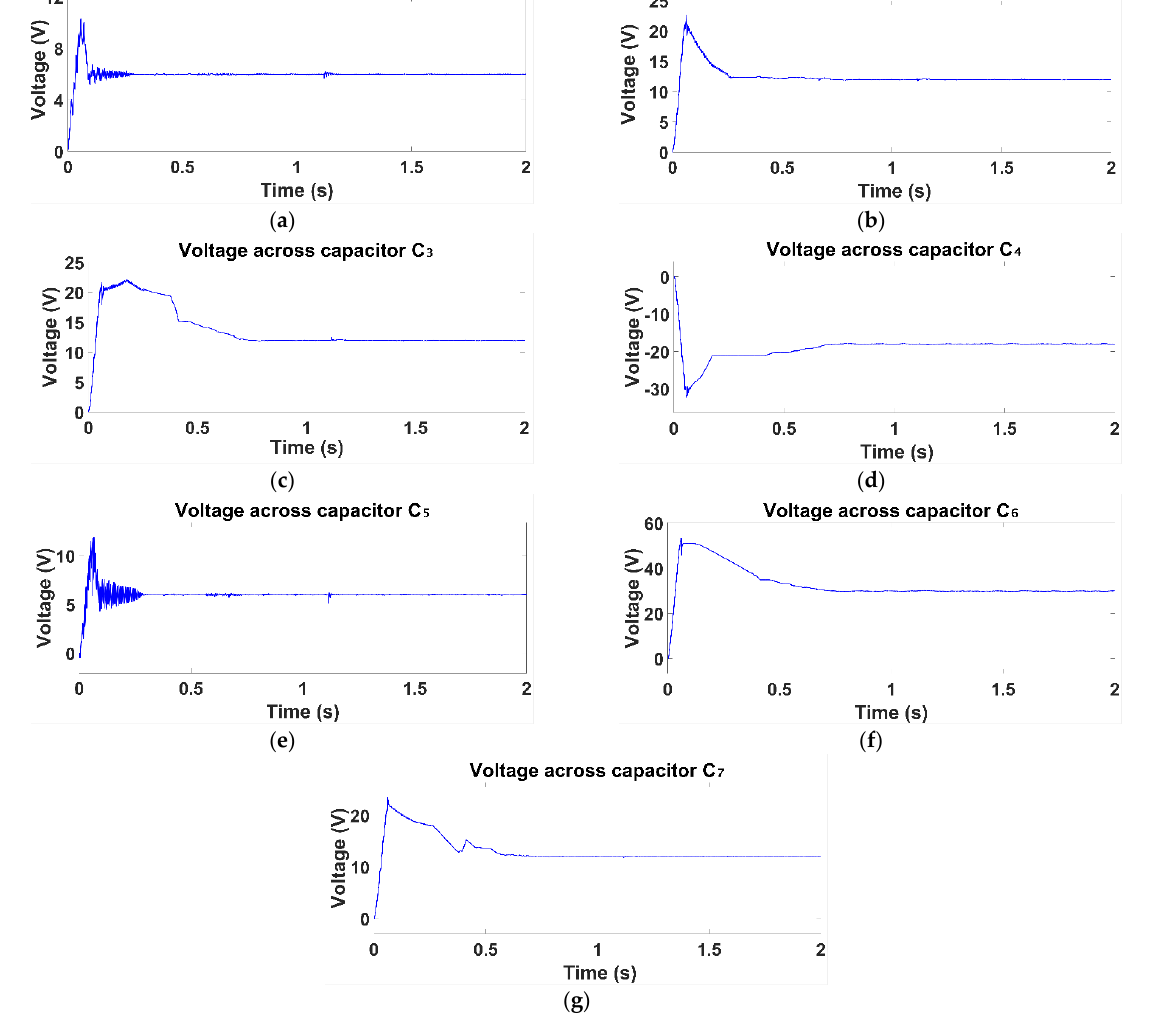
Figure 5. Voltage across capacitors at D = 0.5 and V in = 3 V. ( a ) Voltage across C 1 , ( b ) voltage across C 2 , ( c ) voltage across C 3 , ( d ) voltage across C 4 , ( e ) voltage across C 5 , ( f ) voltage across C 6 , and ( g ) voltage across C 7 .